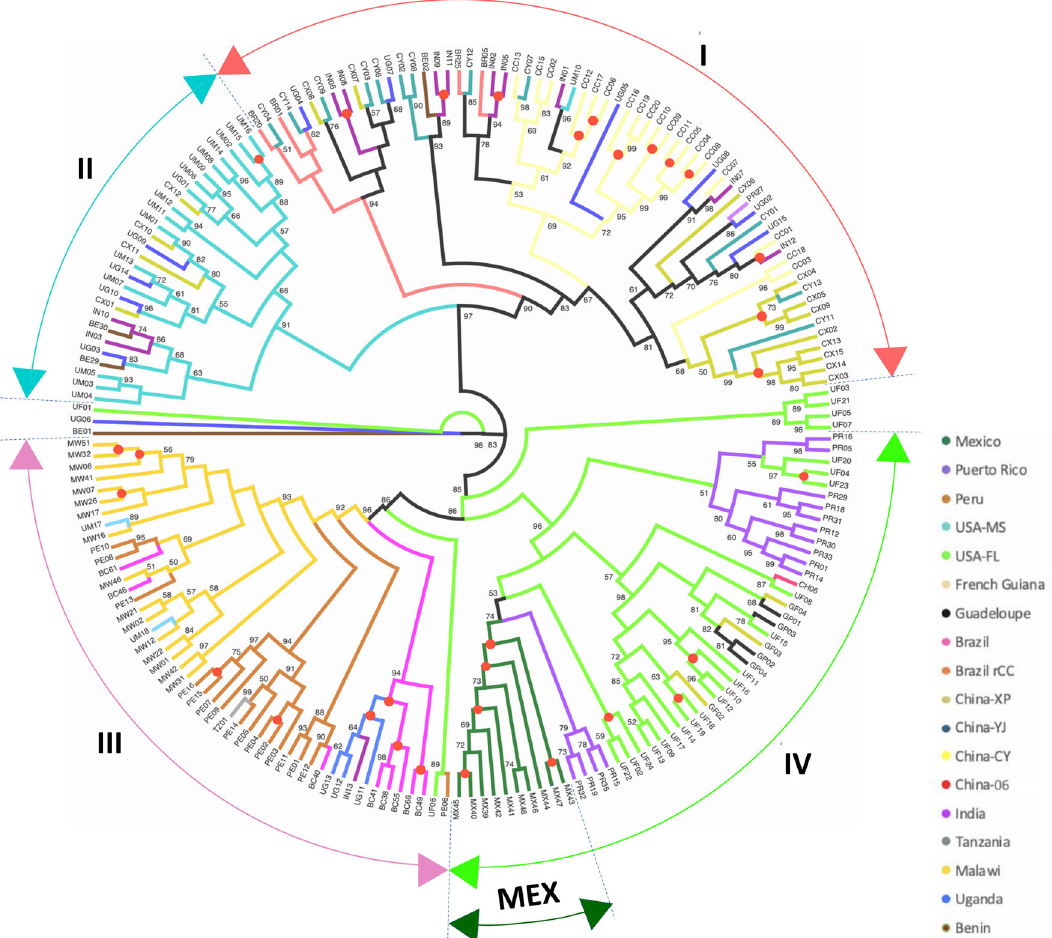
Fig. 3 Maximum likelihood phylogeny of Spodoptera frugiperda populations from the native range of Northern America, Caribbean, South America, and the Old World invasive populations from Africa and Asia as inferred from 870 genome-wide SNP loci. IQ-Tree with 1000 bootstraps replications to estimate node support for Spodoptera frugiperda populations from Northern America (Mississippi, Florida), Caribbean (Puerto Rico, Guadeloupe, French Guiana), and South America (Peru, Brazil), as well as S. frugiperda populations representing the Old World invasive range from Western Africa (Benin), Eastern Africa (Uganda, Tanzania, Malawi), and Asia (India, China). A total of 870 independent SNPs (i.e., unlinked) from non-coding regions distributed across the genome with no missing data were used. Populations are represented by unique colour schemes as indicated. Three populations of S. frugiperda from China Yunnan Province are Cangyuan (CC), Yuanjiang (CY), and Xinping (CX), and two populations of S. frugiperda from Brazil are Brazil-CC (BC) and Brazil-rCC (BR). Branch nodes with 100% bootstrap support are indicated by red dots. Bootstrap values of <50% are not shown. The legend shows branch colours of sampling